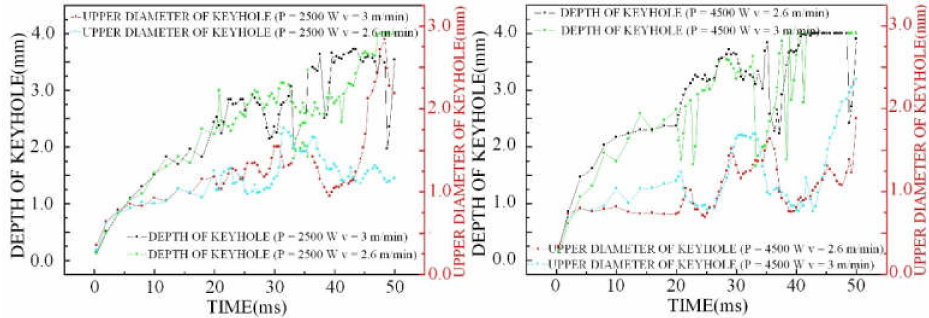
Figure 9. Effect of welding speed on keyhole depth and outlet diameter of keyhole